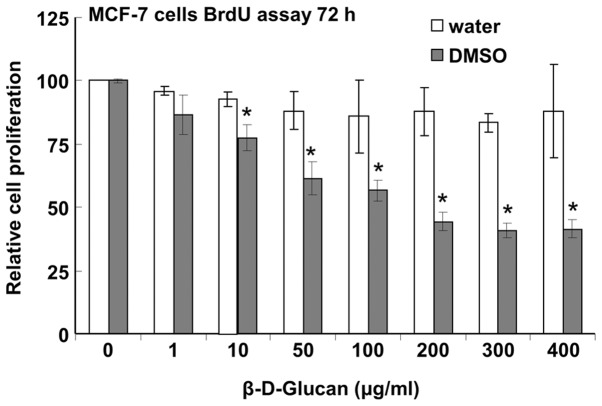
β-D-glucan dissolved in DMSO but not water inhibits MCF-7 cell proliferation. MCF-7 cells were incubated in phenol red-free IMEM + 5% DCC and the indicated concentrations of β-D-glucan dissolved in water or DMSO for a total of 72 h with a medium/treatment change after 48 h. Values are the mean ± SEM for 4 separate values in one experiment for β-D-glucan in water and 6 separate experiments (biological replicates) for β-D-glucan in DMSO. Values of β-D-glucan in DMSO were corrected for the inhibitory effect of DMSO on cell proliferation. *p<0.05 vs. control (Student’s t-test). The IC50 value for β-D-glucan in MCF-7 cells was 164 μg/ml (calculated in Excel).